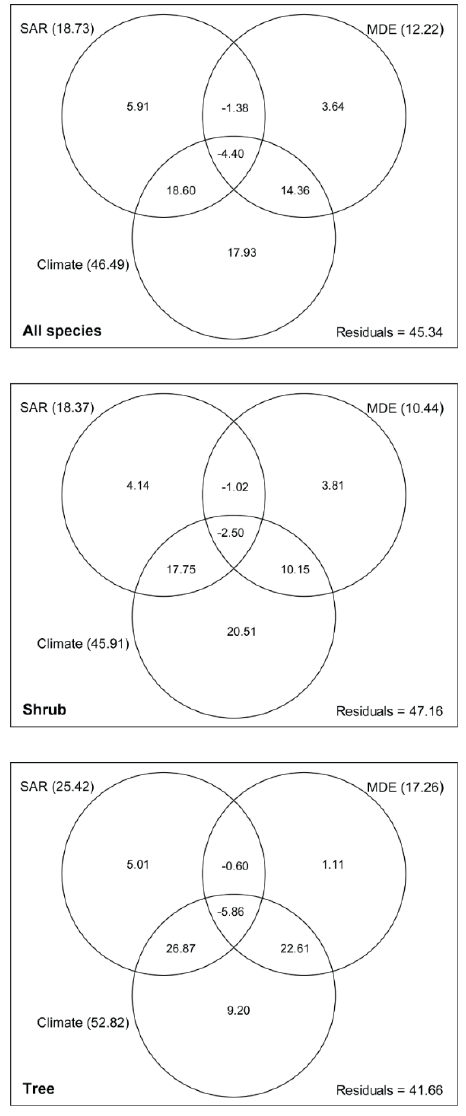
Figure 5. Partitioning of species richness into the species–area relationship (SAR), the mid-domain effect (MDE), and climate components for all species, and for shrubs and trees. Values represent adjusted R 2 coefficients of independent or shared effects by 3 predictors. Total effect (including independent and shared effects) of each explanatory component was shown in parentheses.